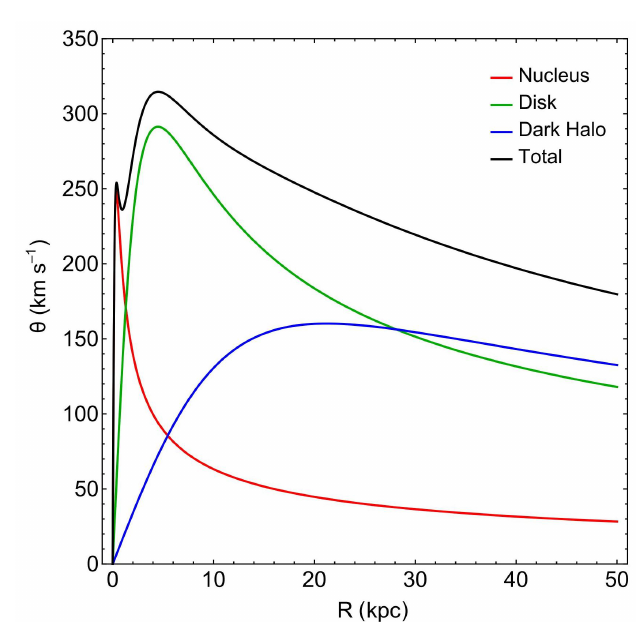
Fig. 1. A plot of the rotation curve in our galactic model. We distinguish the total circular velocity (black) and also the contributions from the central massive nucleus (red), the disk (green) and that of the dark matter halo